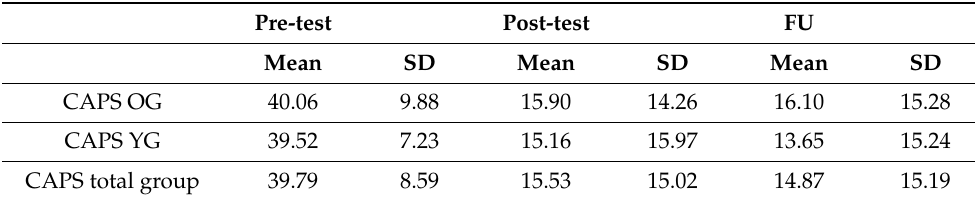
Table 3. Pre, post-treatment and follow-up means and SDs, for the follow-up (FU) samples, older group ( n = 31), younger group ( n = 31), and total group ( n = 62). Pre-test Post-test FU Mean SD Mean SD CAPS